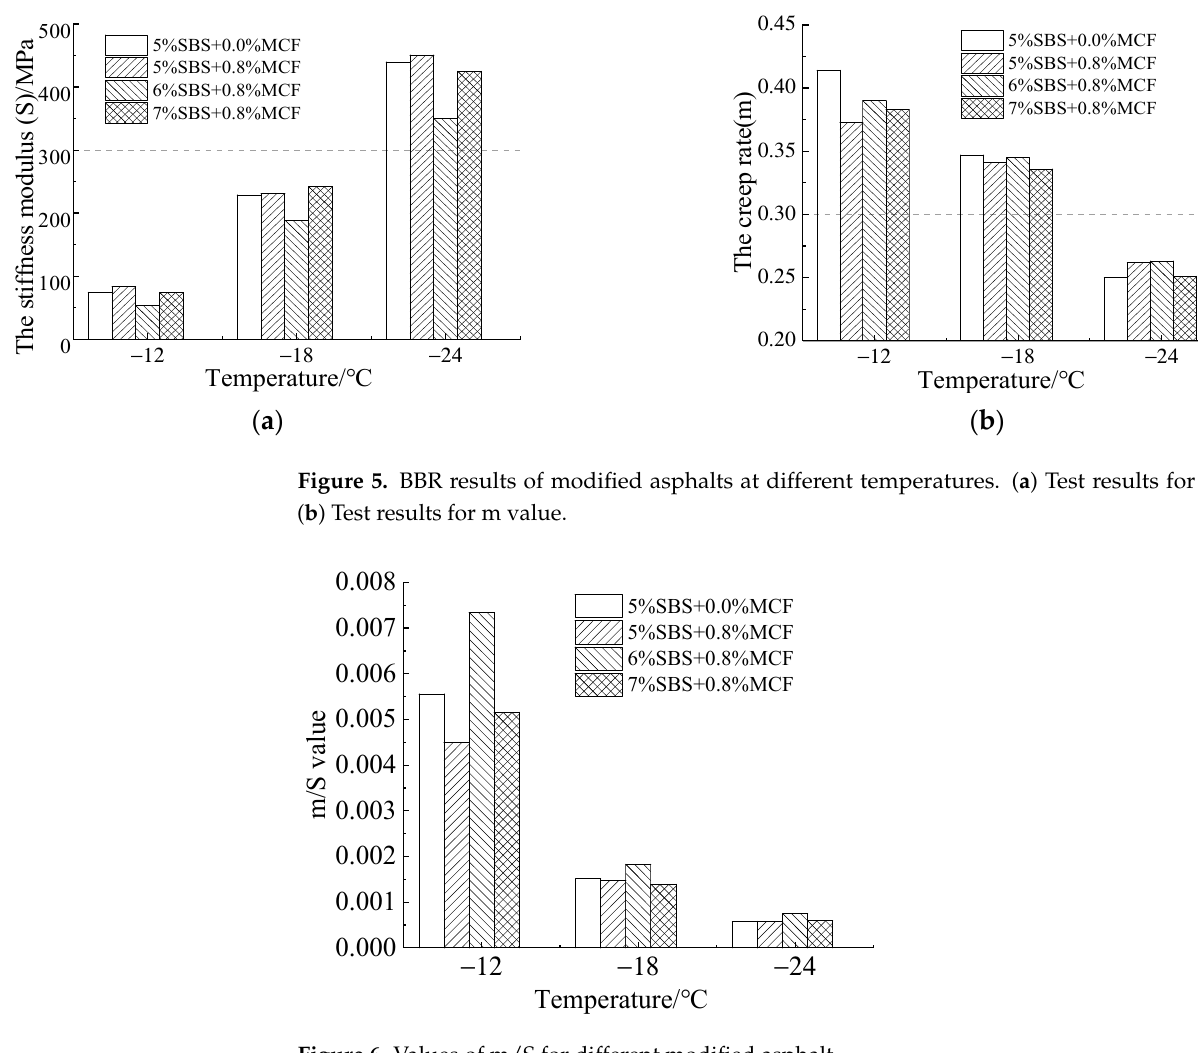
Figure 6. Values of m/S for different modified asphalt.